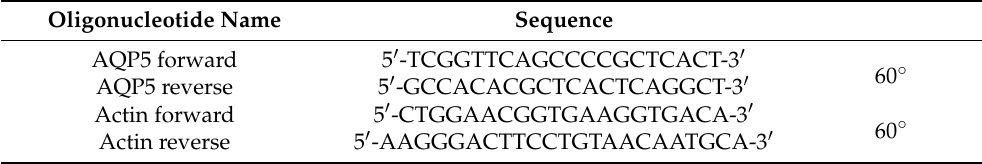
Table 4. Oligonucleotide pairs used for quantitative PCR- AQP5 mRNA